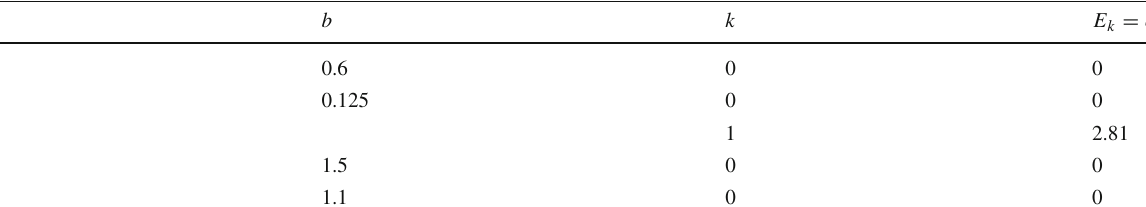
Table 1 Number of bound states and their eigenvalues for different values of the parameters b and c